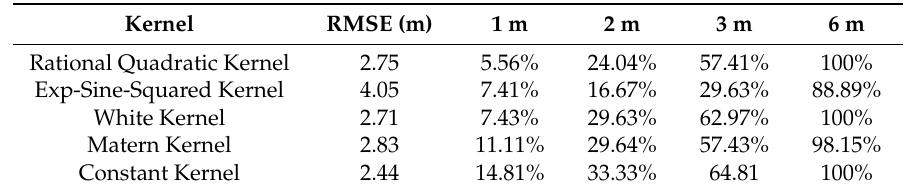
Table 3. Localization results in testing area.